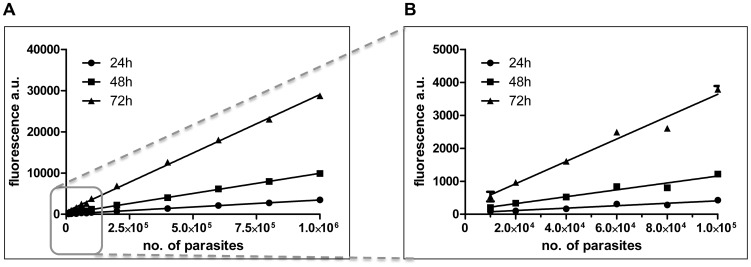
Linear correlation of the number of L. donovani amastigotes and the reduction of Alamar blue.
L. donovani amastigotes were isolated from the spleen of an infected Rag-2 −/− mouse. Up to 106 (A) or 105 (B) parasites were suspended in 200 µl/well in supplemented RPMI, Alamar blue was added and the plate incubated at 26°C. At the indicated time points, the fluorescence per well was determined and plotted over the initial number of parasites/well. The correlations between Alamar blue conversion and the initial parasite numbers are highly significant: P<0.0001 as shown by linear regression analysis (R224h– 0.9979, R248h – 0.9991, R272h – 0.9984).